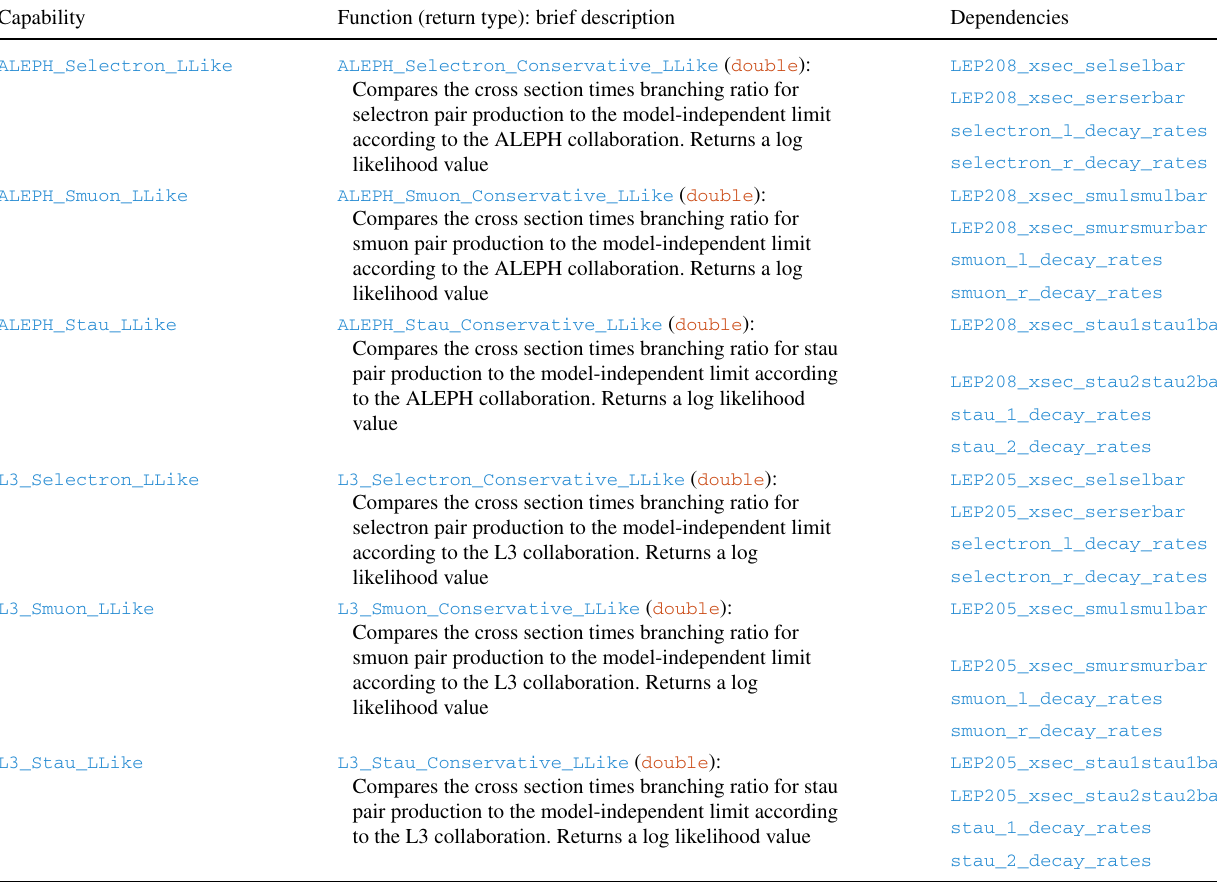
Table 12 The slepton LEP limit capabilities provided by ColliderBit . In addition to the dependencies shown above, all of these functions also depend on GAMBIT ’s MSSM30atMGUT [1] model parameters and